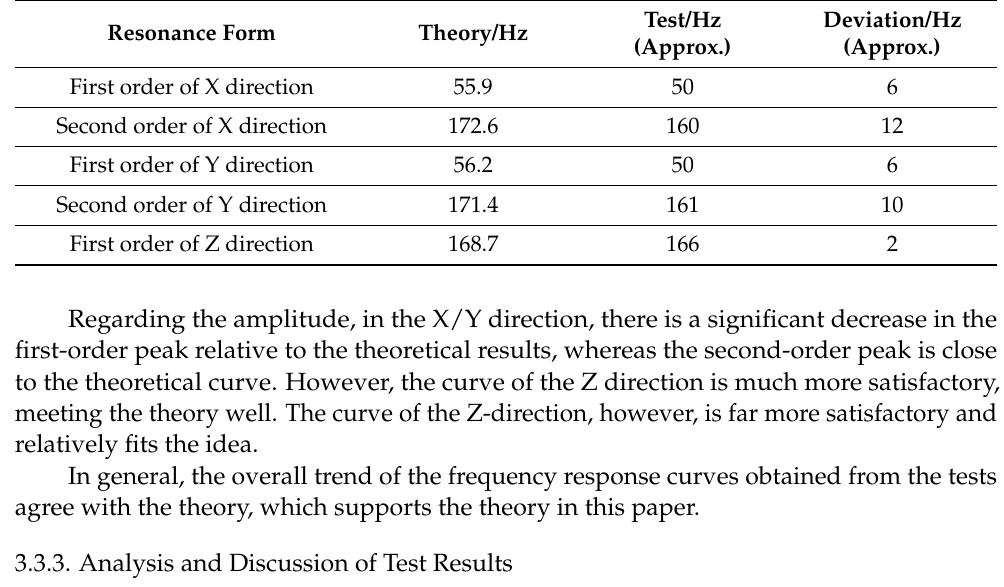
Table 6. Resonant frequency of the curves obtained by theory and